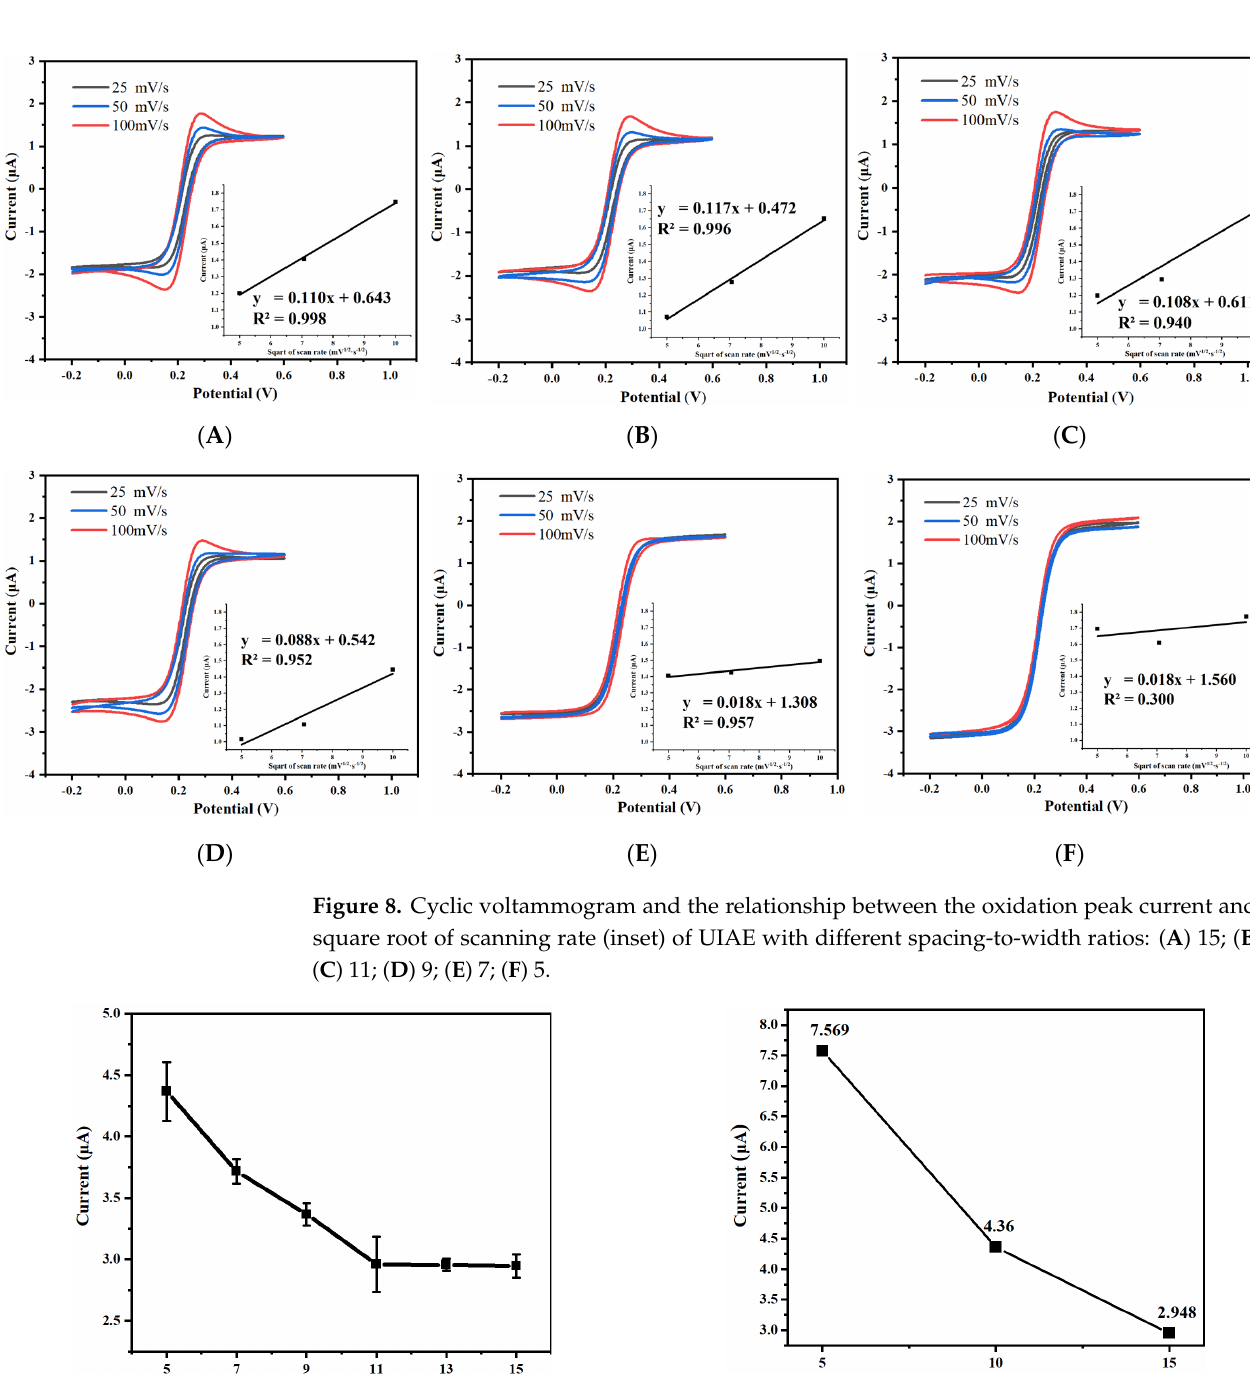
8 of 15 Figure 7. Comparison of electrochemical cyclic voltammetric characteristics between UIAE and UBAE with the spacing-to-width ratio of 13.